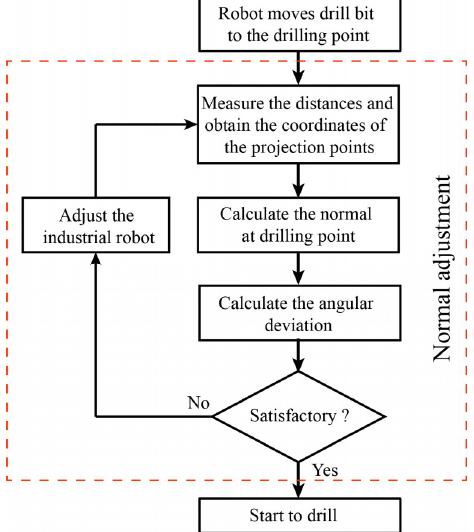
Figure 2. The flow of normal adjustment of robotic drilling system.